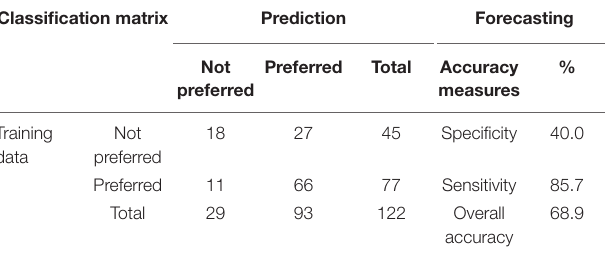
TABLE 2 | Classification matrix of CHAID for physical and social